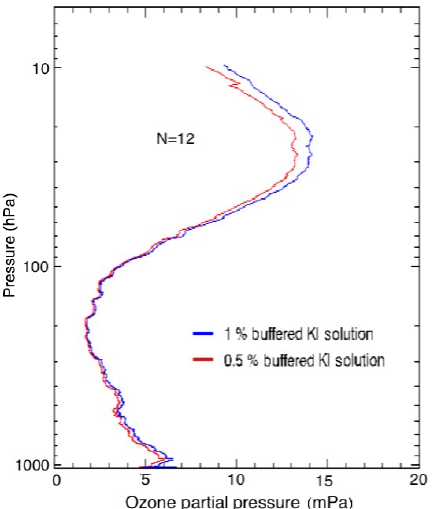
Figure 4. Average ozone profiles from 12 pairs of SPC 6A ECC ozonesondes indicating at the 22hPa pressure level that the (0.5%, 0.5B) ECCs measured 0.7–0.8mPa less ozone, approximately 7% less, than the (1.0%, 1.0B) ECCs.